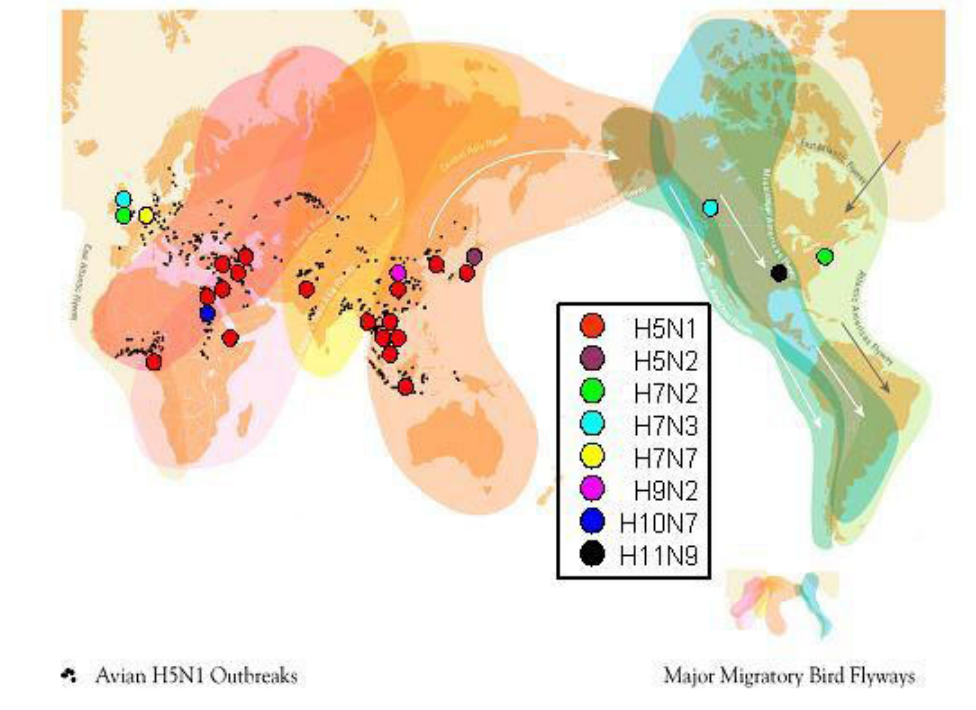
Fig. 1. Global distribution of reported human infections with avian influenza viruses, laboratory-related cases excluded, as of March 2008. Avian H5N1 outbreak records are as of March 2008 and include poultry, and free-living or captive wild birds. Migratory bird flyway configurations after Olsen et al.(2006), based on migration data from Wetlands International for sandpipers, plovers, snipes, and allied taxa of the Order Charidriiformes. Arrows show potential transit routes for H5N1-infected migratory birds from Asia and Europe into the